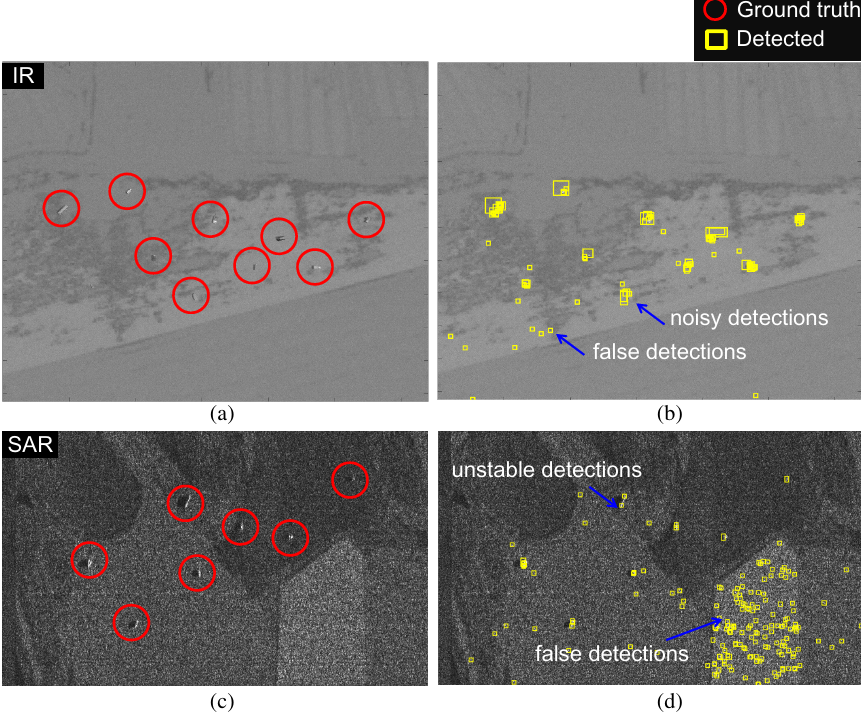
Figure 5. Problems with the original BMVT-based SAR/IR target detection: ( a ) IR test image; ( b ) BMVT-based IR target detection; ( c ) SAR test image; ( d ) BMVT-based SAR target detection.